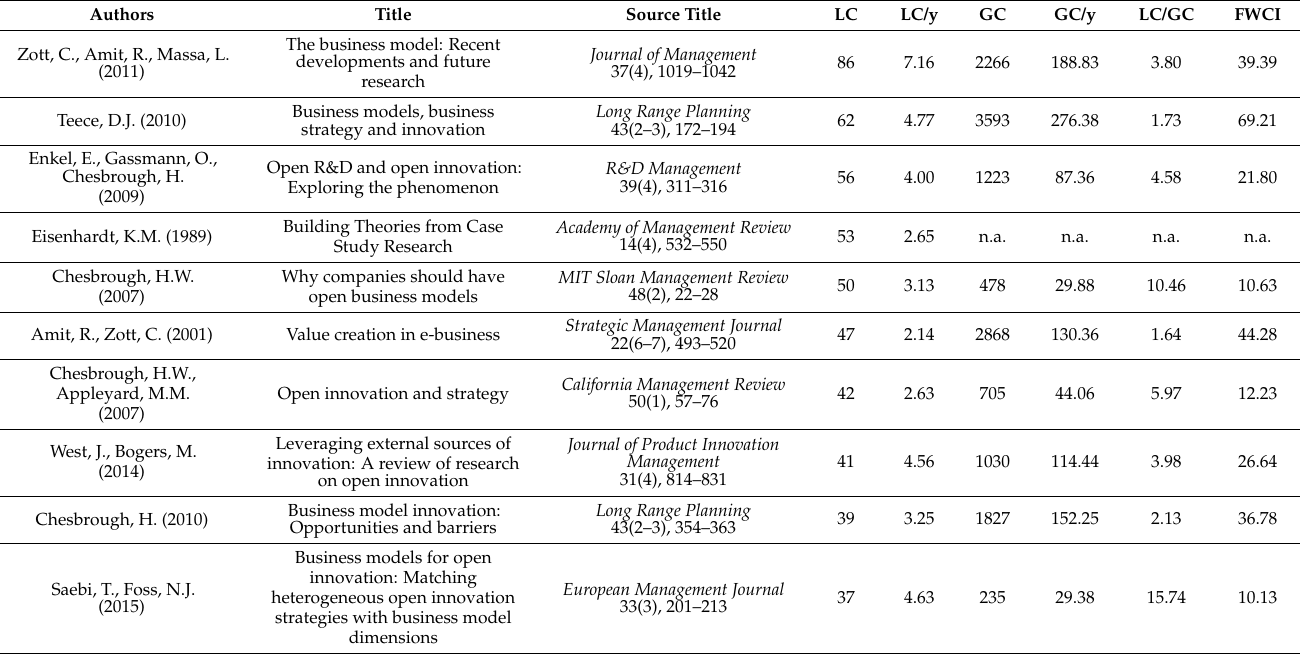
Table 3. Most cited references by publications covering the BM&OI